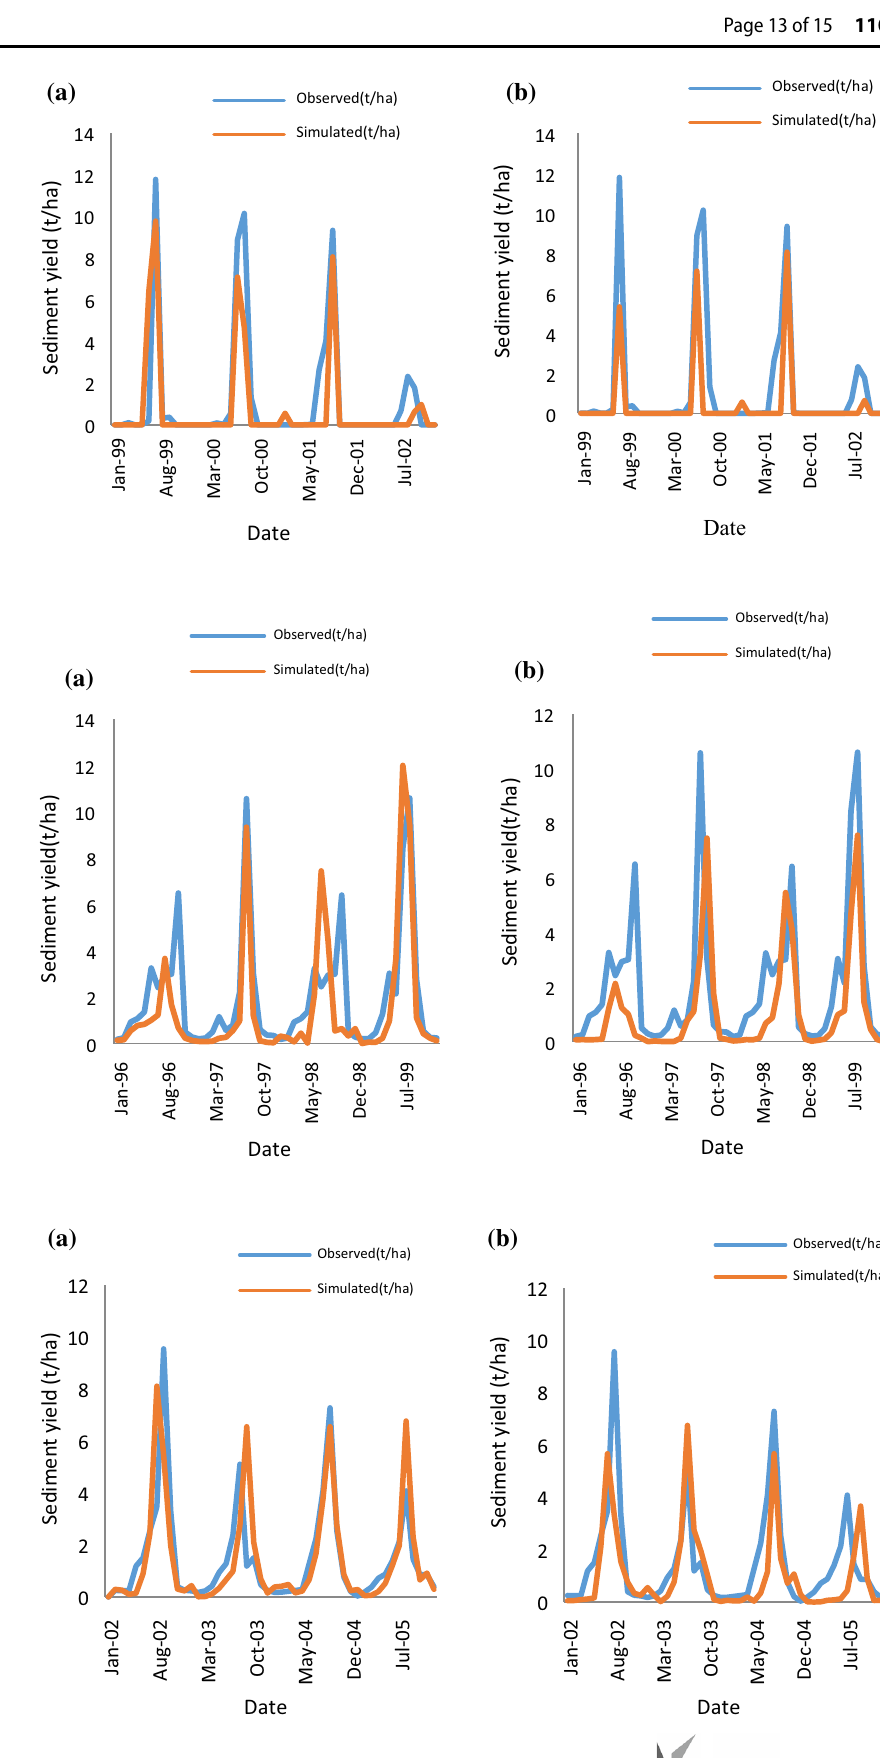
Fig. 18 Observed and simulated monthly sediment yield for model validation (2002–2005) of Pandoh dam for a ERA- Interim and b IMD weather